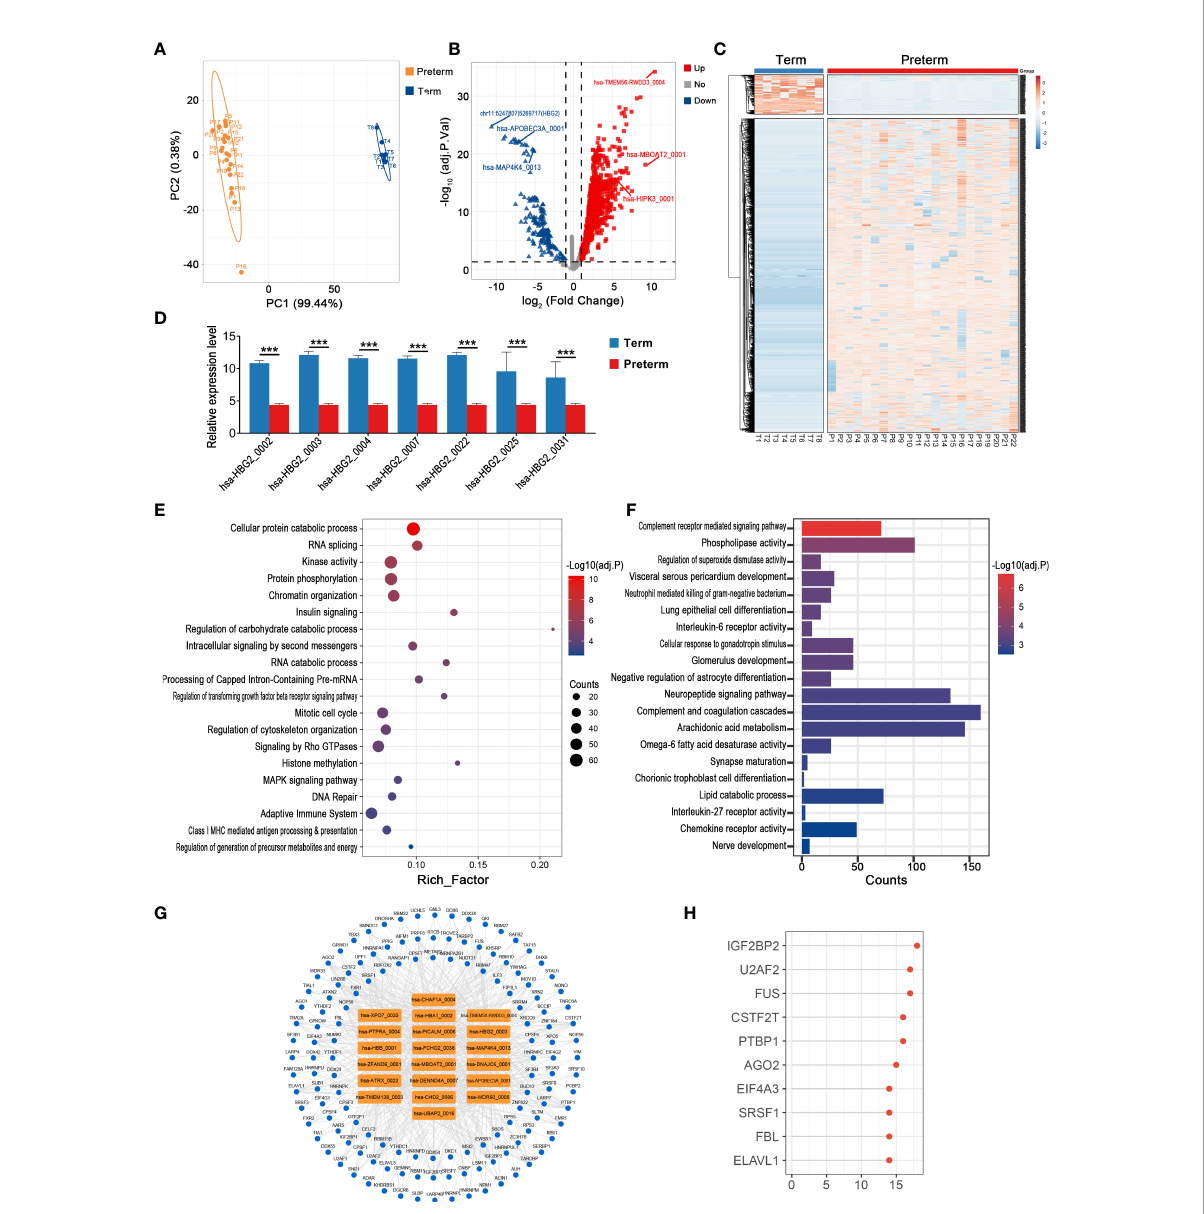
FIGURE 7 The circRNA changes and functional analyses in the cord blood of PTB. (A) PLS-DA of circRNA expression in preterm (yellow points) and term (blue points) cord blood. (B) The volcano plot of circRNA changes and adj. p-values in the cord blood of PTB. (C) The hierarchical clustering of DECs expression in term and preterm cord blood. (DECs: |log2 (fold change)|> 1 and adj. p-value < 0.05). (D) The expression levels of DECs originated from HBG2 in preterm and term cord blood. (E, F) Functional enrichment analysis for co-expressed mRNAs (E) and target miRNAs (F) of DECs in preterm cord blood. (G, H) The DECs-RBPs network and the top 10 RBPs in the cord blood. (*** indicate p <